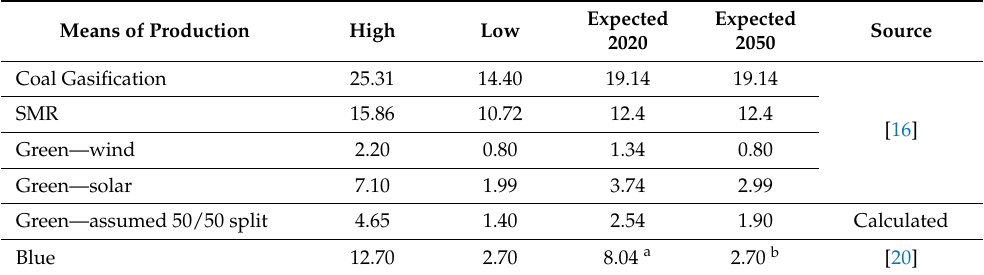
Table 2. Assumed life cycle emissions (in kgCO 2 eq./kgH 2 in GWP100) for hydrogen produced by different